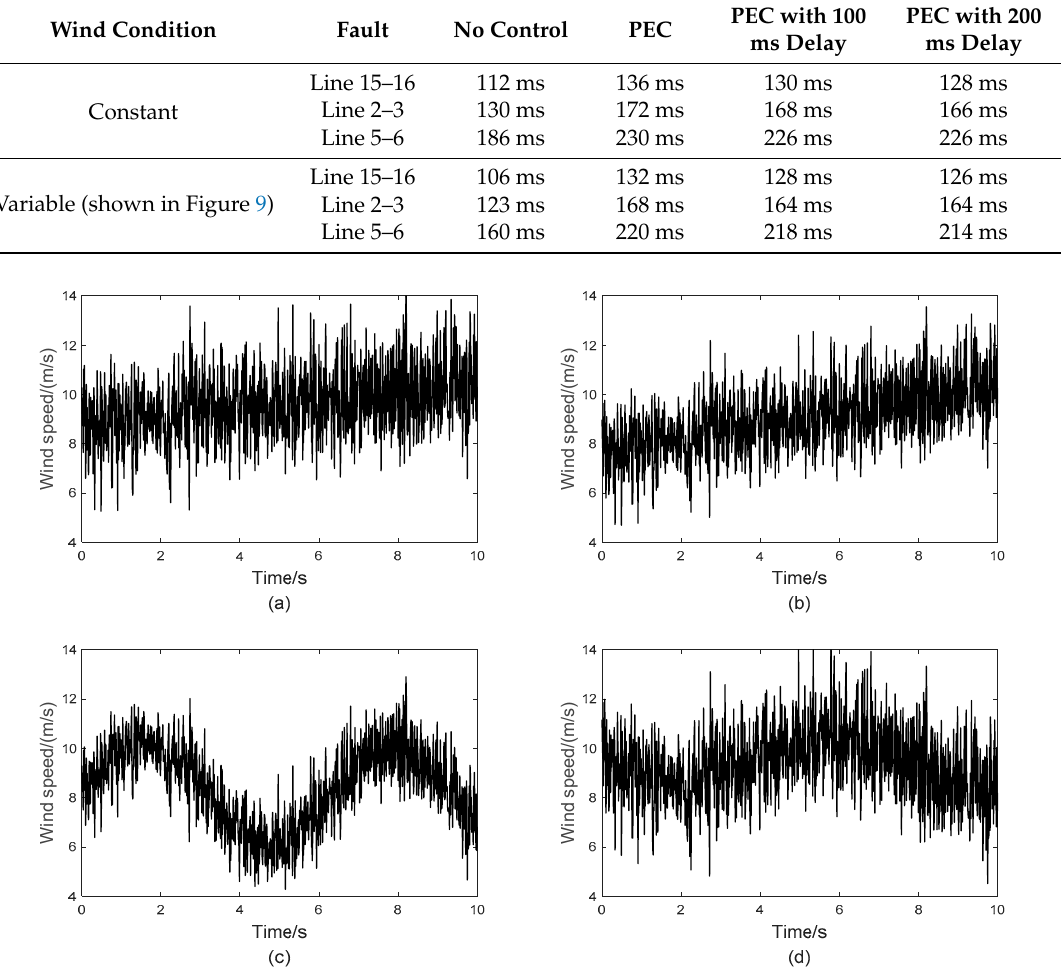
Figure 9. Wind speed of ( a ) W 1 ; ( b ) W 2 ; ( c ) W 3 ; and ( d ) W 4 .